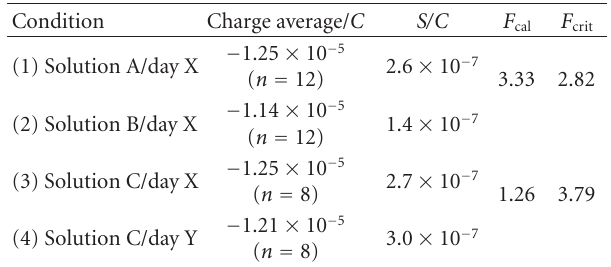
Table 1: Charges obtained for mercury film electroplating under di ff erent conditions.